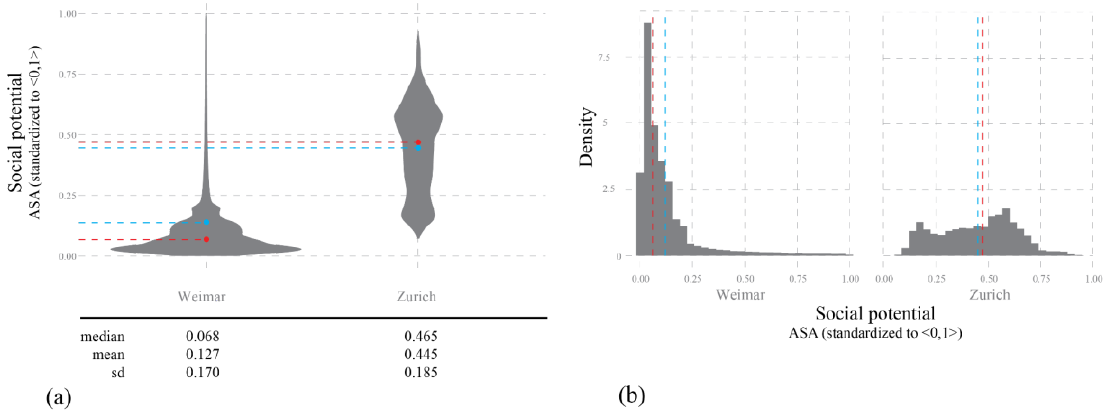
Figure 5. Distribution of ASA (measure potential for social interaction) across the two case studies. ( a ) Violin plot, with highlighted median (red) and mean (blue) values; ( b ) histogram with highlighted median (red) and mean (blue).